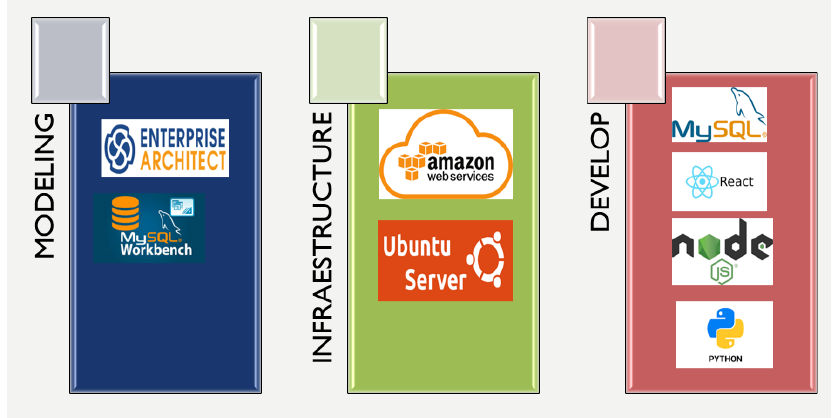
Figure 3. Tools used for the development of the platform.